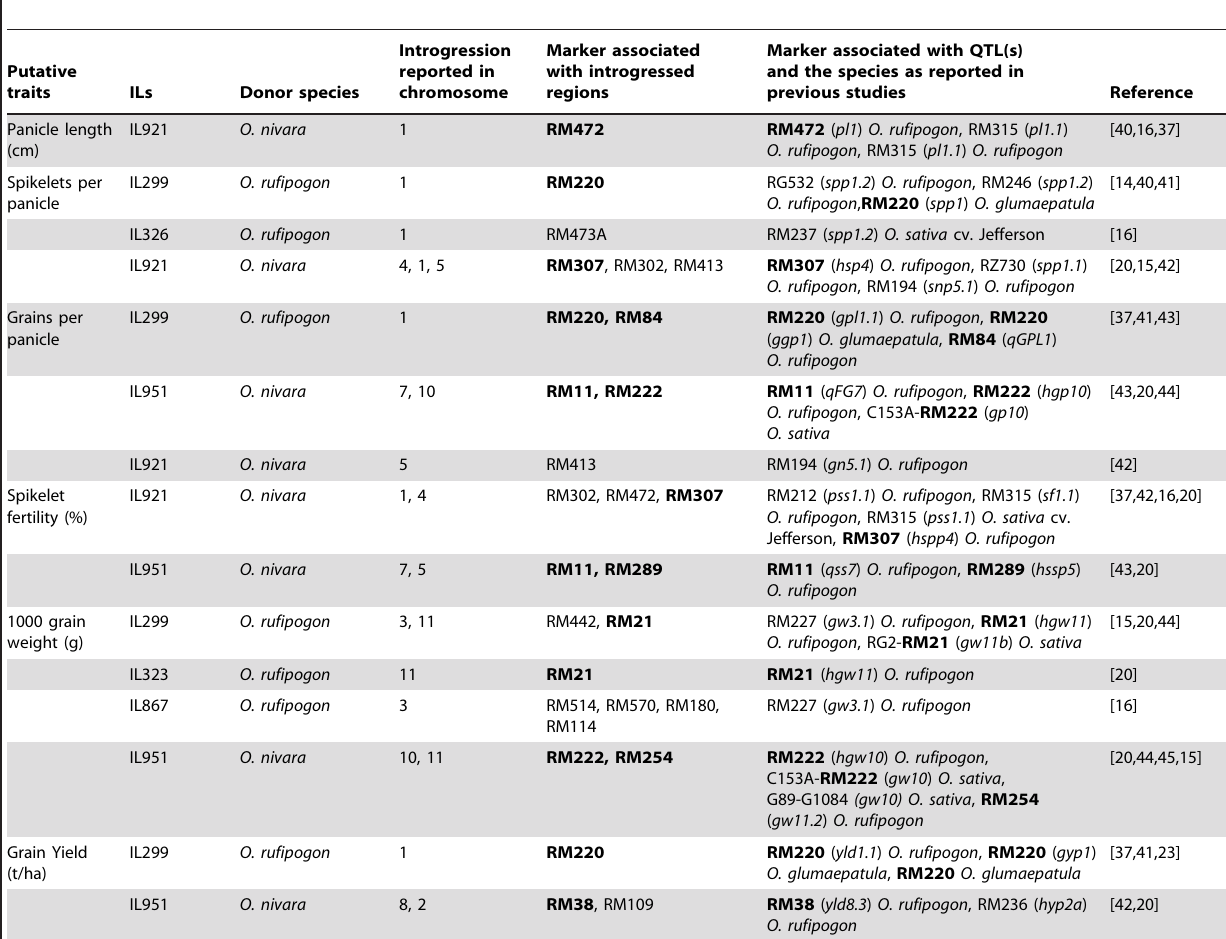
Table 4. Correspondence of reported introgressions from O. rufipogon and O. nivara with the already reported quantitative trait locus/loci.